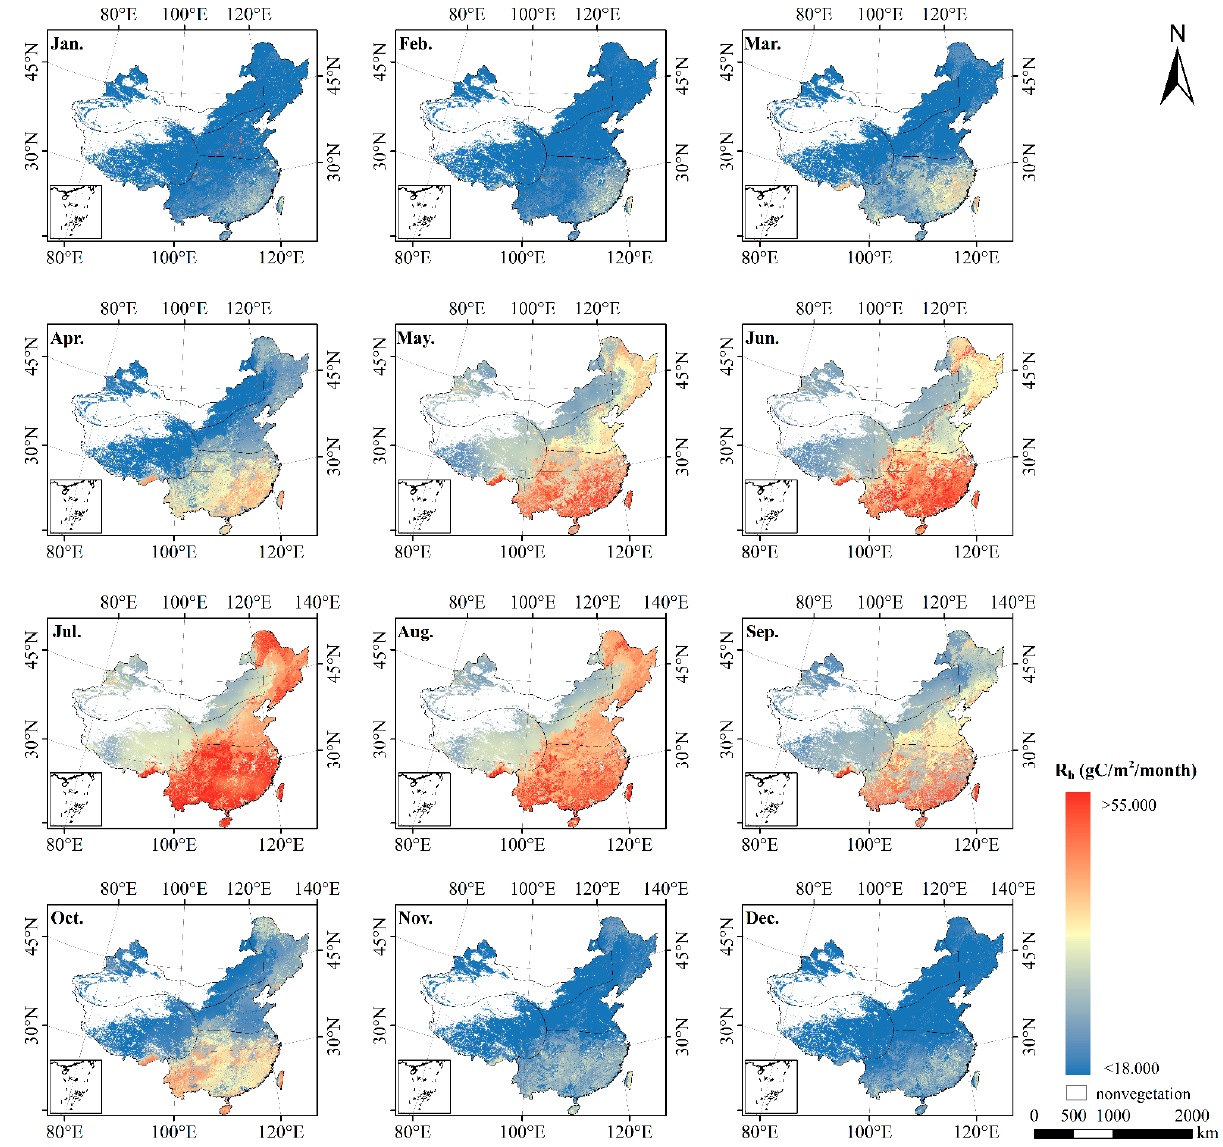
Figure 4. Spatial pattern of the monthly R h over China during 2010 by the GSMSR and R s –R h relationship model.